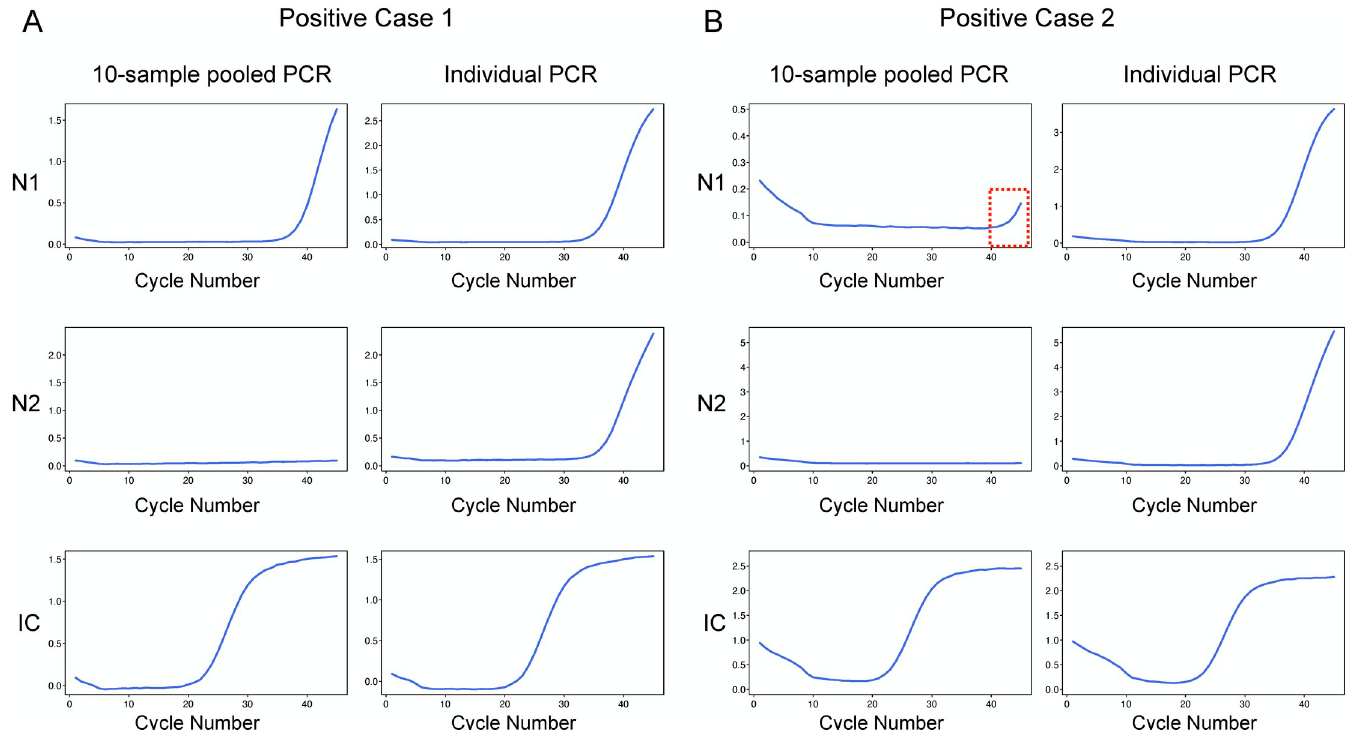
Fig 1. PCR amplification curves for positive case 1 (A) and positive case 2 (B). Upper panel, N1; middle panel, N2; lower panel, internal control (IC) gene. Left column of each panel, 10-sample pools; right column of each panel, individual samples.